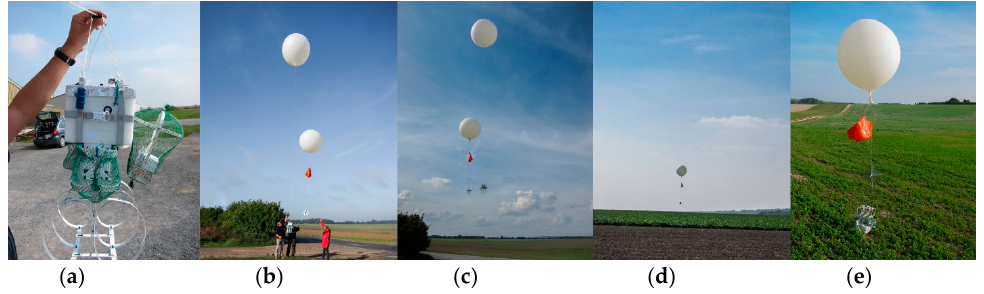
Figure 9. The different flight stages of AMULSE. ( a ) The instrument is securely attached to the two-balloon system and ready to fly. Stages ( b , c ) corresponds to the beginning of the flight while ( d ) shows the pre-positioning determined by the flight simulation software in order to recover the instrument ( e ).